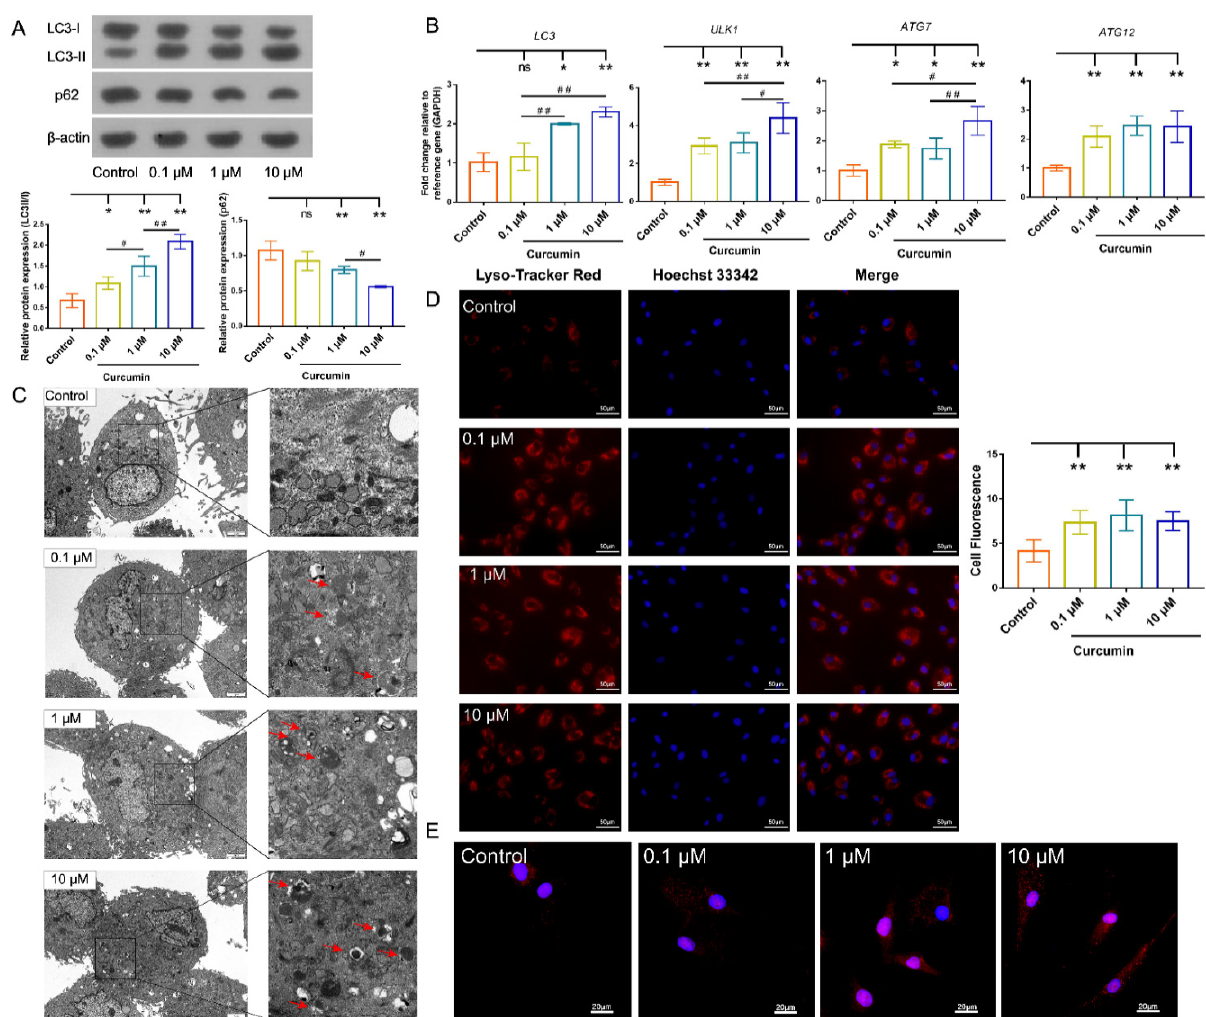
Figure 4. Effects of Cur on the autophagy of cBMSCs (P6). ( A ) Immunoblots showing the protein expression levels of p62, LC3-I, and LC3-II in BMSCs treated or untreated Cur (0.1, 1, and 10 μ M), β -actin was used as the loading control. ( B ) The relative expression of LC3 , ATG12 , ATG7 , and ULK1 in cBMSCs were analyzed using RT-qPCR. ( C ) The ultrastructure of cBMSCs with or without Cur treatment was examined by transmission electron microscopy. The red arrows show autophagosomes and autolysosomes; scale bars = 2 µ m. ( D ) cBMSCs were treated or untreated with Cur (0.1, 1, and 10 µ M) and then stained with LysoTracker Red DND-99 (60 nM). The relative fluorescence intensity at the intracellular level was quantified using the Image Pro Plus software; scale bars = 50 μ m. ( E ) Representative immunofluorescence images show LC3 punctae (red) in BMSCs; scale bars = 20 μ m. * p < 0.05, ** p < 0.01 compared with the control group. # p < 0.05, ## p < 0.01 for intragroup comparisons.